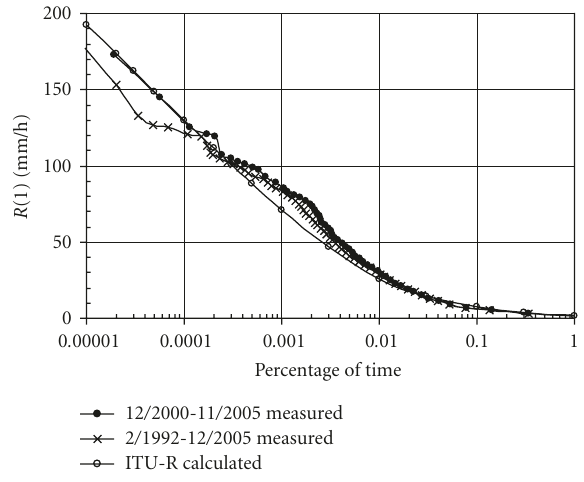
Figure 2: CDs of average 1-minute rain intensities for